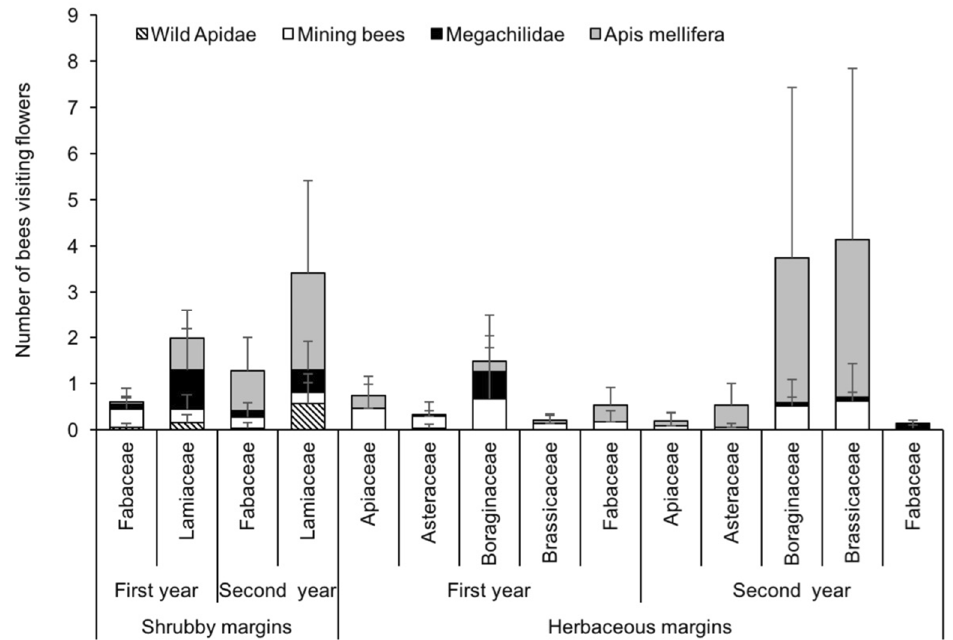
Figure 5. Annual averages of the different bee groups ( A. mellifera , wild Apidae, mining bees and Megachilidae) observed in 2 × 2 m squares over a four-minute period in shrubby, herbaceous and control margins (means ± SE).